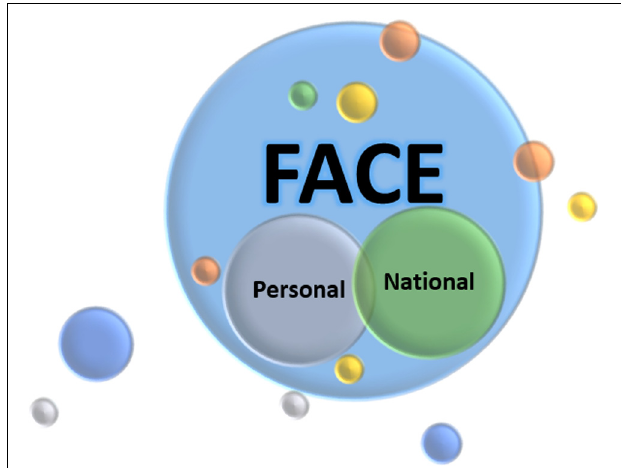
FIGURE 1 | Two types of face, as represented at the personal and national